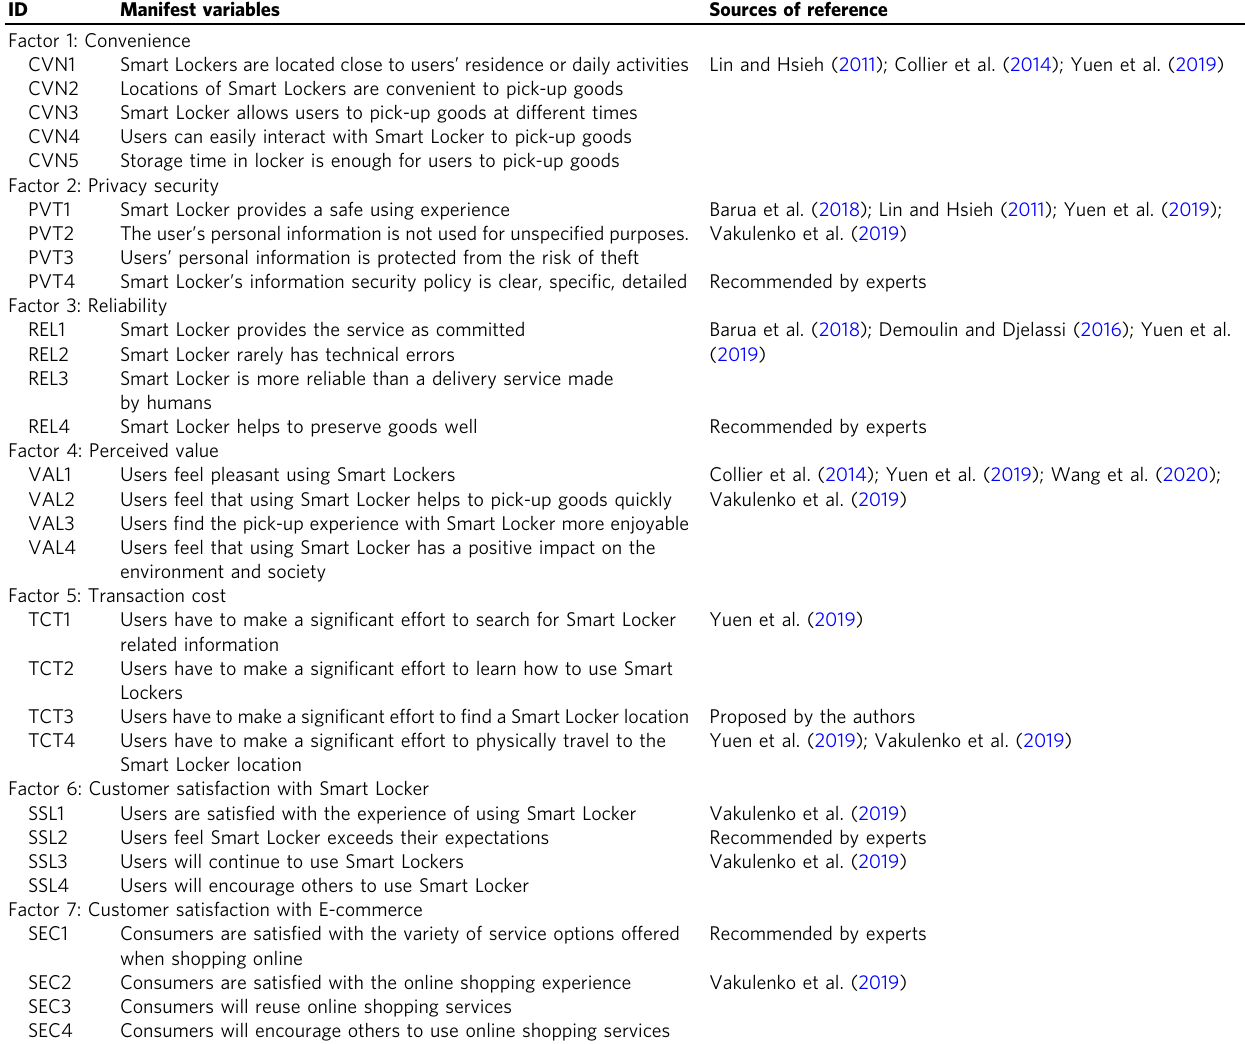
Table 2 Constructs and measurement items.